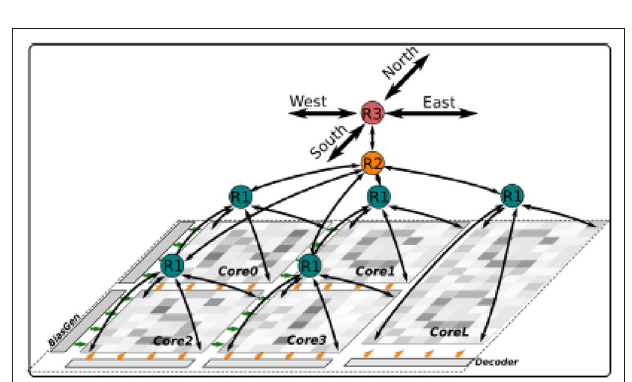
FIGURE 15 | Dynap-SEL with hierarchical routers. Each Dynap-SEL comprises four TCAM-based non-plastic cores and one plastic core. The hierarchical routing scheme is implemented on three levels for intra-core (R1), inter-core (R2), and inter-chip (R3)